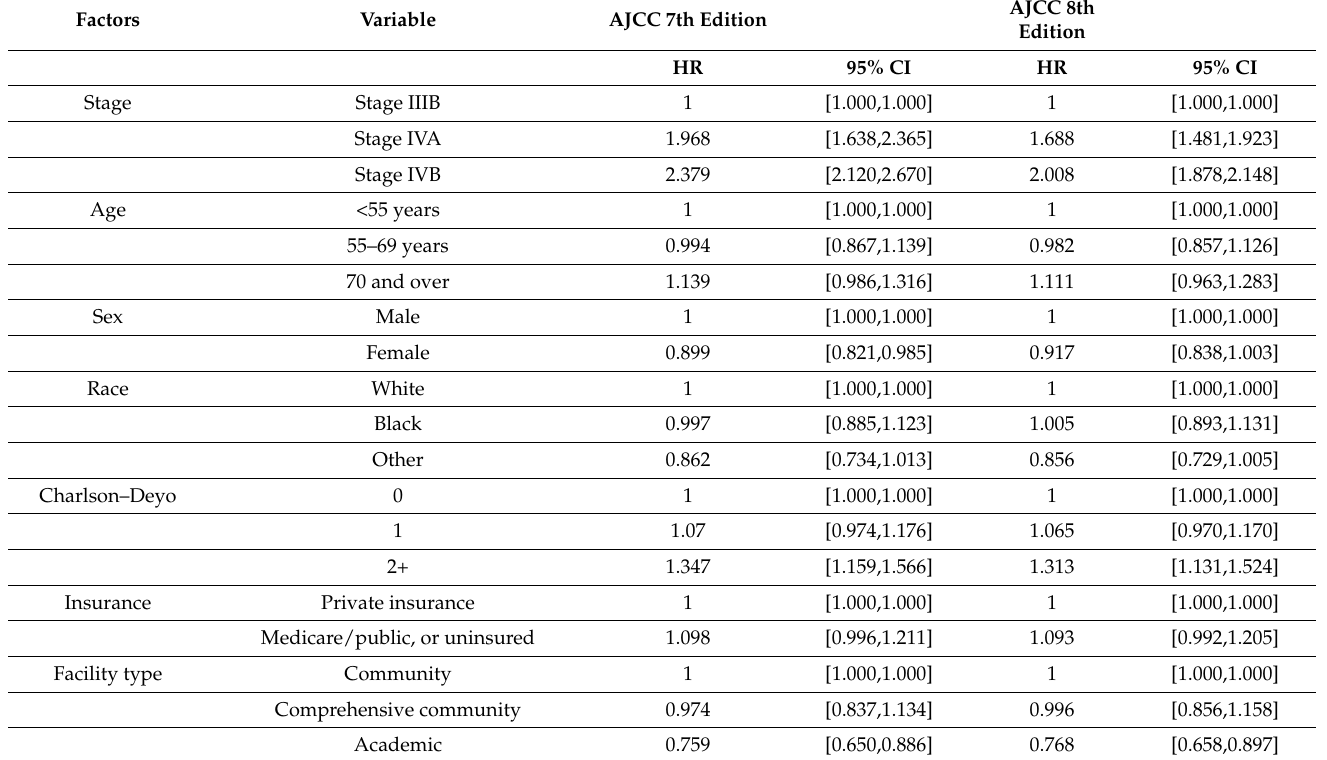
Table 5. Factors associated with risk of death in GBC patients with stage ≥